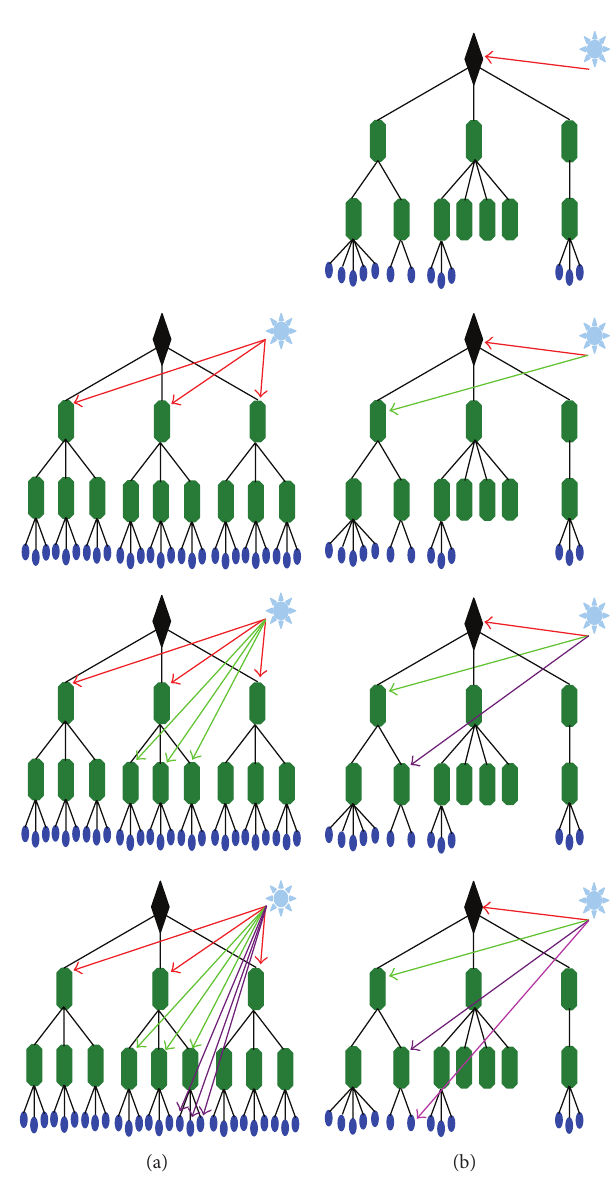
Figure 3: Traditional classification (a) and new clustering technique